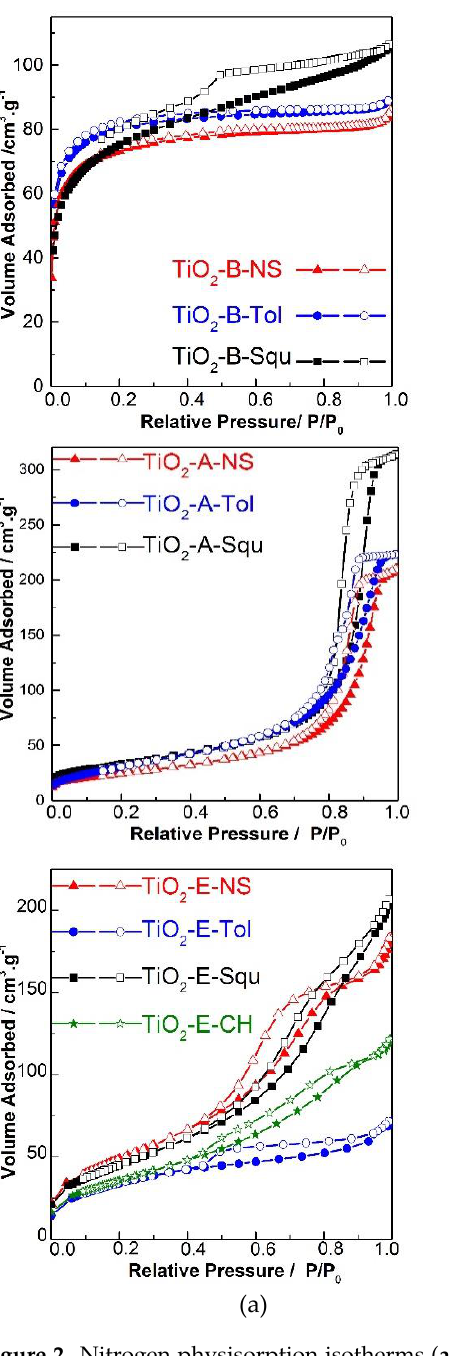
Figure 2. Nitrogen physisorption isotherms ( a ) and pore size distribution ( b ) of non-calcined TiO 2 samples. Filled and open symbols refer to adsorption and desorption, respectively.